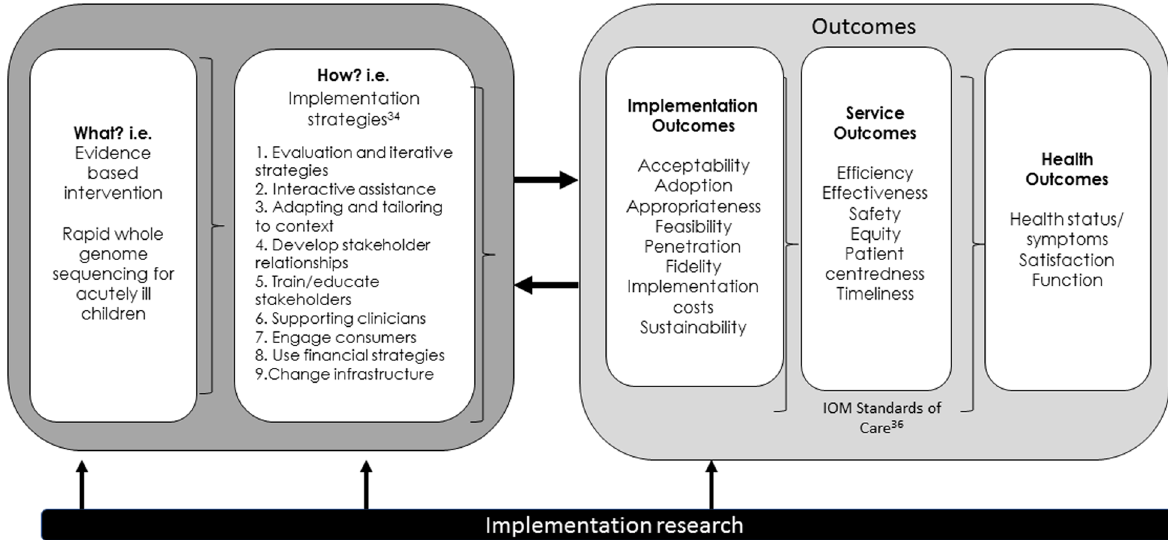
Fig. 5 Identifying implementation strategies and outcomes using the Conceptual Model of Implementation Research 32,41 . This step by step model fi rst identi fi es ‘ what ’ is being implemented (here, rapid whole genome sequencing for acutely ill children). The ‘ how ’ then lists potential implementation strategies that could support implementation. The ‘ what ’ and the ‘ how ’ lead to three programme outcomes – Implementation, Service and